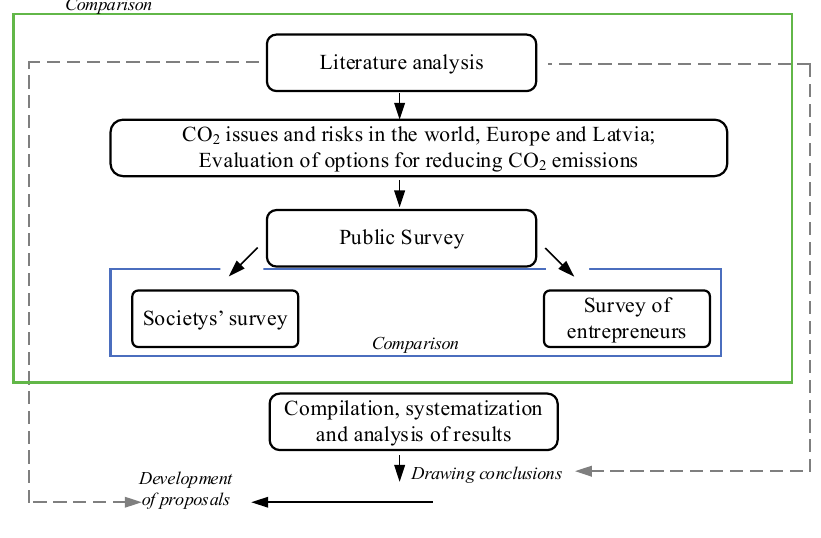
Fig. 2. Algorithm of the